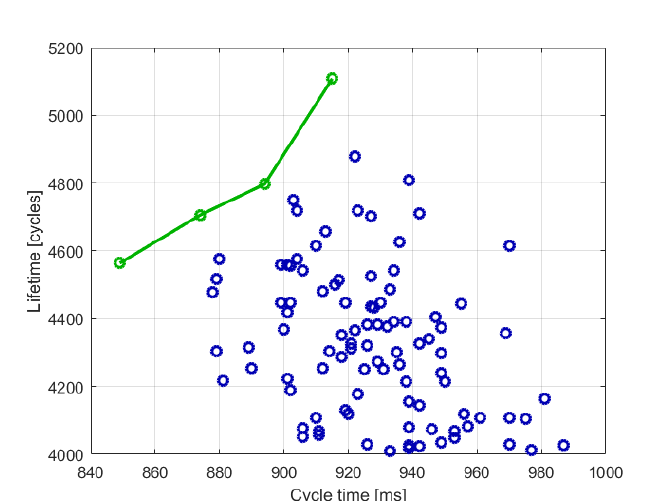
Figure 10. Optimal solutions found by SNO in the cycle time–lifetime plane. The green represents the Pareto front.